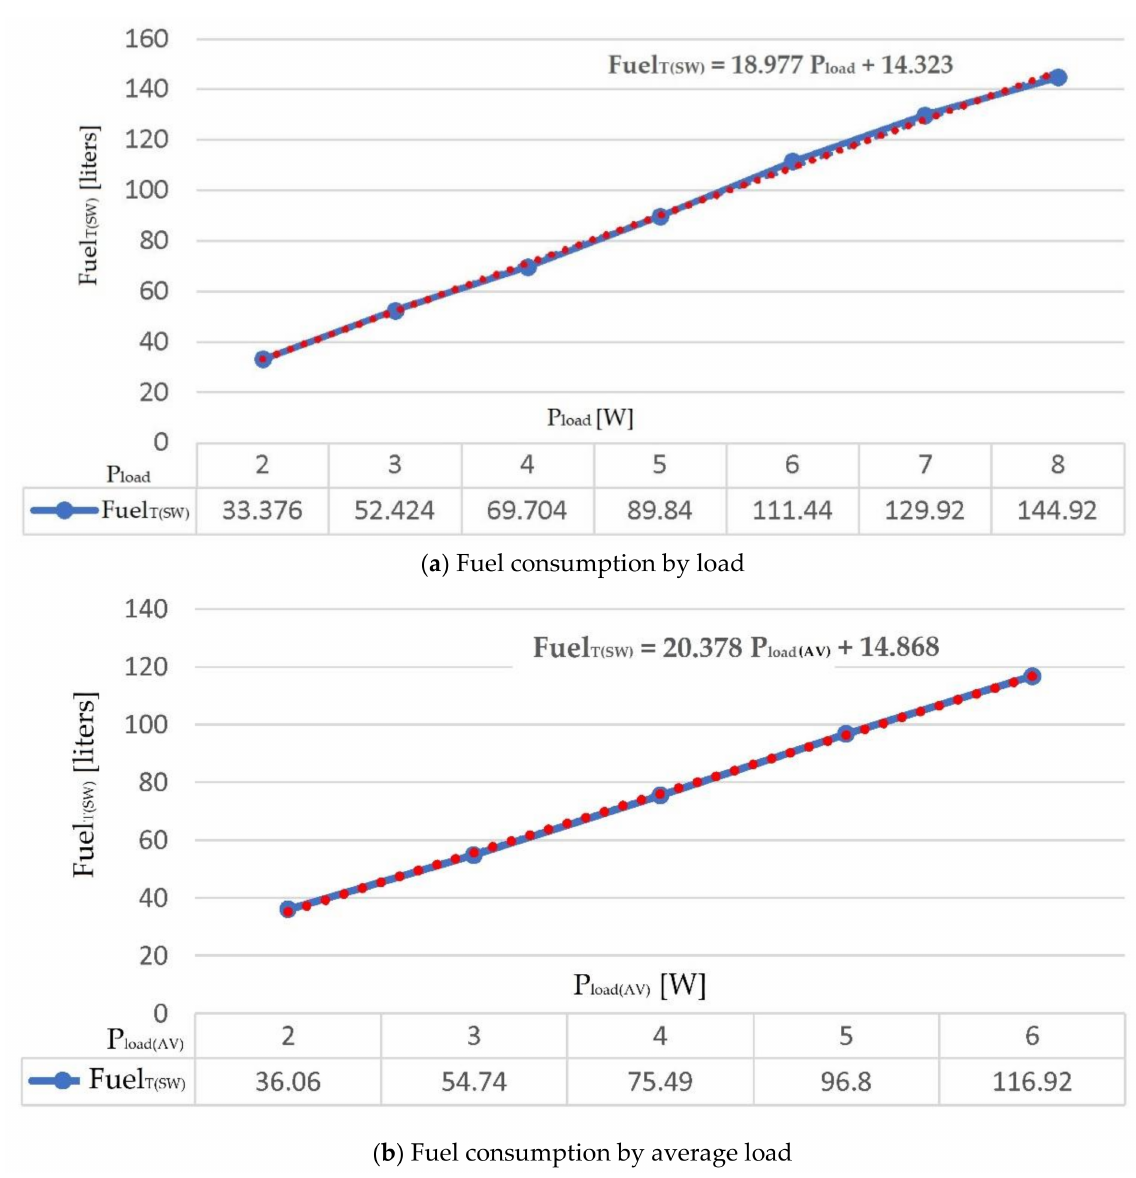
Figure 9. Fuel consumption for the SW–LFW